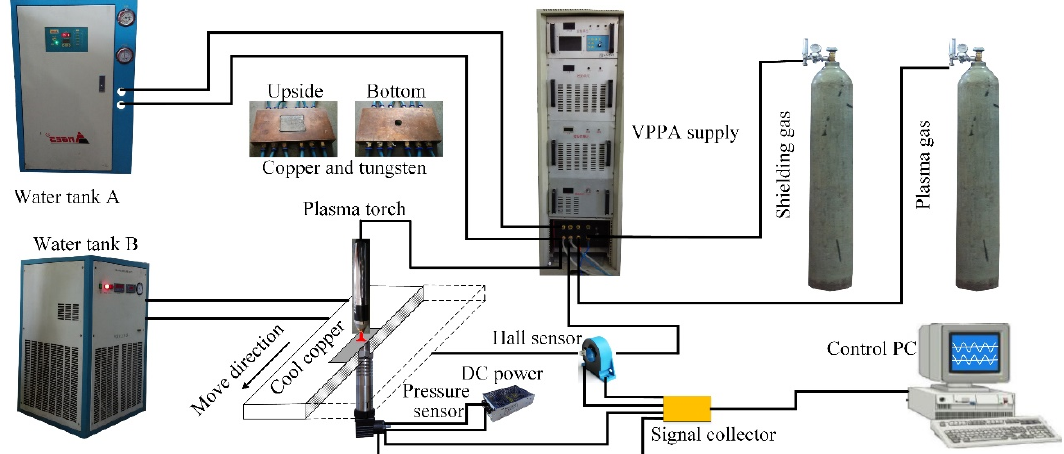
Figure 5. Experimental system of measuring variable polarity plasma arc pressure.